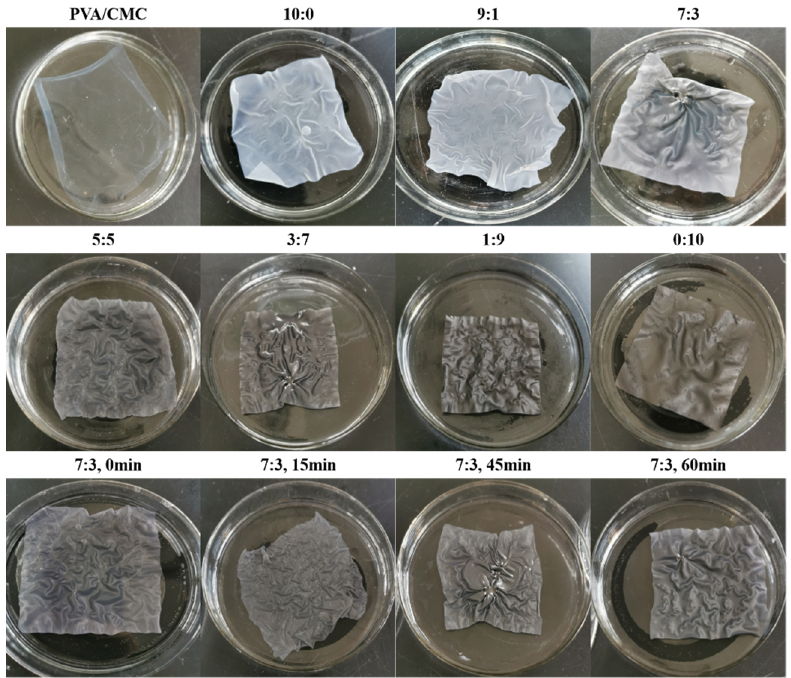
Figure 1. The dissolution and swelling conditions of PVA/CMC, PVA/CMC/ZnO NPs, PVA/CMC/ZnO NPs/xGnP (ZnO NPs:xGnP = 9:1, 7:3, 5:5, 3:7, 1:9), PVA/CMC/ x GnP film with 30 min ultrasonication and PVA/CMC/ZnO NPs/xGnP (ZnO NPs: x GnP = 7:3) composite films under different ultrasonication times.